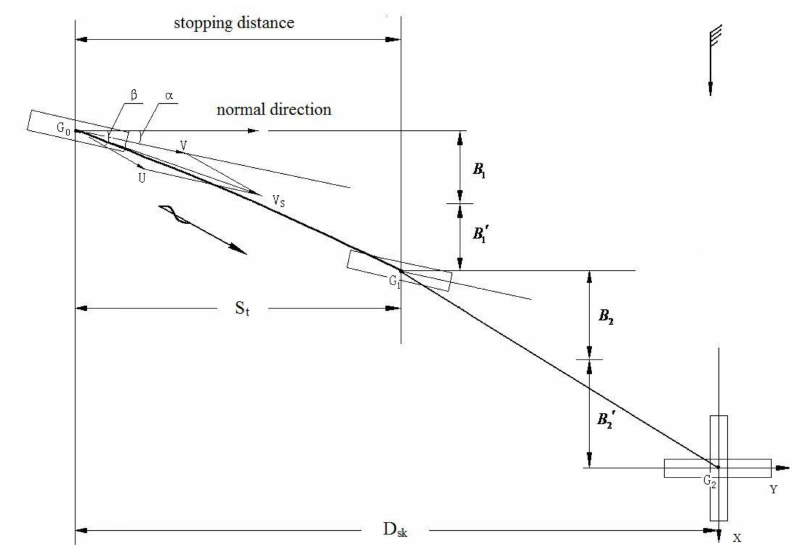
Figure 4. Drifting stages of the ship that is out of control